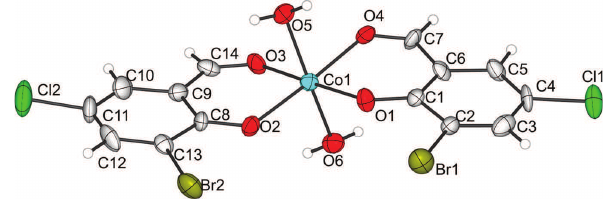
Table 1: Crystal collection and